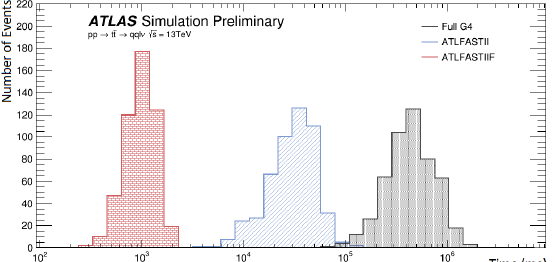
Figure 4. Comparison between G eant 4 and two fast simulators, the fast calorimeter simulation (la- belled as ATLFASTII) and the fast chain (labelled as ATLFASTIIF), in the CPU performance of event processing time. Simulations were performed in Athena release 21.3.8 on semi-leptonic t ¯ t events. Sim- ulation benchmarks were performed using the BNL USATLAS Tier-3 Cluster which consists of 300 nodes, each with 8 2.6GHz CPUs and 16GB of memory. 500 events were produced in a single run. No pile-up is simulated. From Ref.